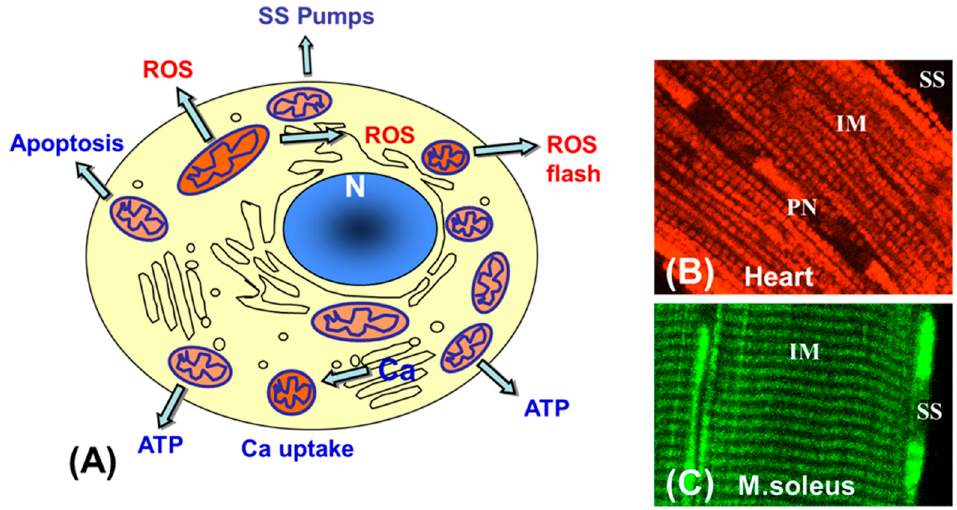
Figure 4. Mitochondrial heterogeneity and subpopulations. Mitochondrial subsets may have different region-specific specializations depending on their intracellular localization and environment ( A ). Mitochondrial subpopulations in a cardiac cell: SS—subsarcolemmal, IM—intermyofibrillar and PN—perinuclear mitochondria visualized by TMRM (red) ( B ). SS (subsarcolemmal) mitochondrial clusters in soleus muscles (M. soleus) visualized from the auto-fluorescence of mitochondrial flavoproteins, fluorescent in their oxidized state (green) ( C ).